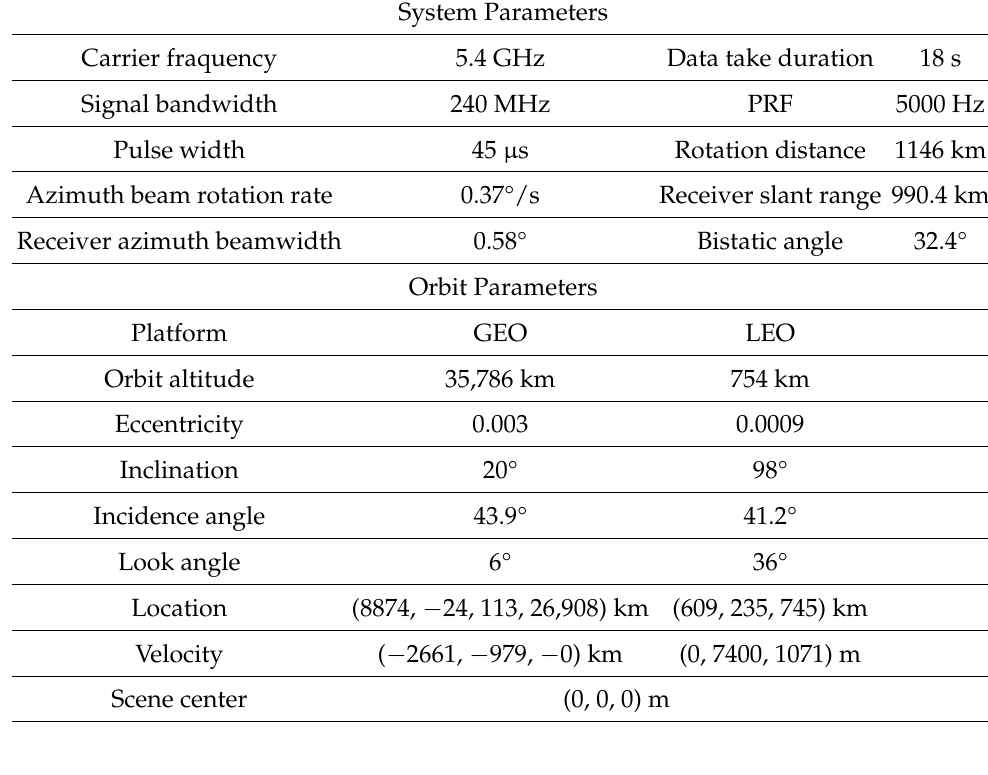
Table 1. Simulation parameters of sliding-spotlight GEO-LEO BiSAR.